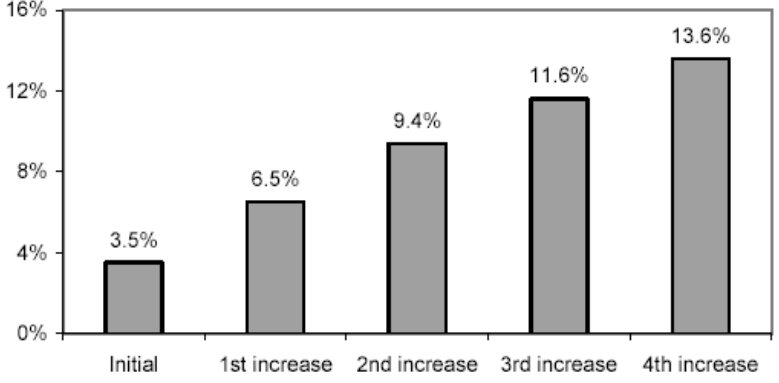
Figure 2. Contribution rates in SMART plans. Source: Thaler and Benartzi (2004).